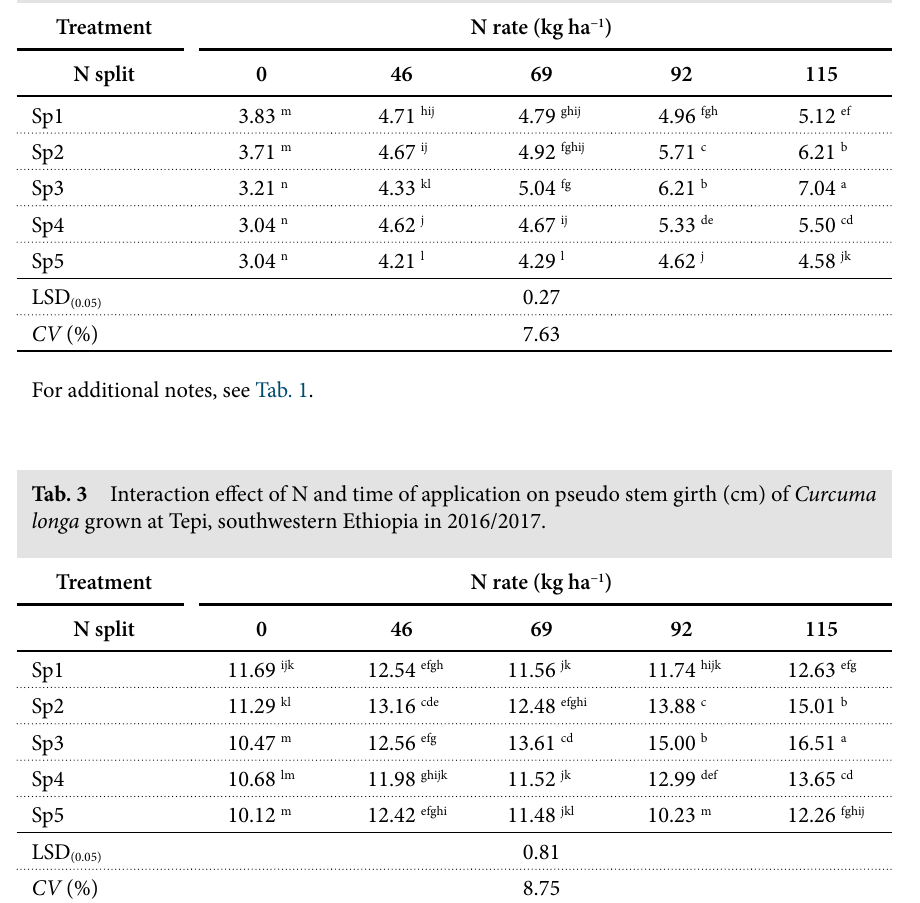
grown at Tepi, southwestern Ethiopia in